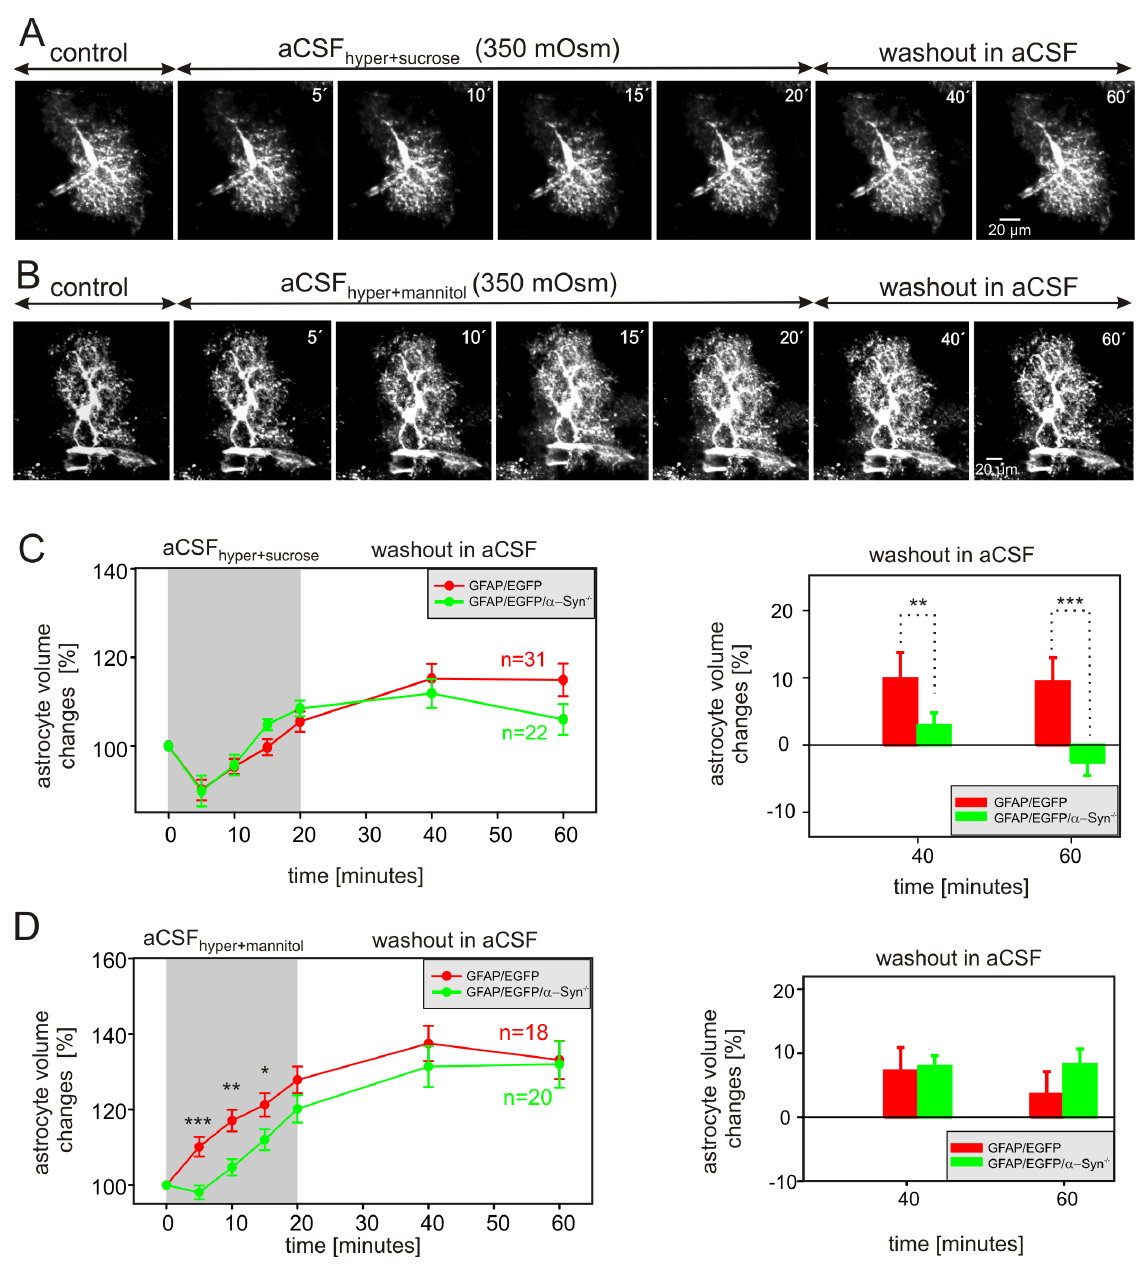
Figure 5. Astrocytic volume changes in the cortex of GFAP/EGFP and GFAP/EGFP/ a -Syn 2 / 2 mice during hyperosmotic stress. ( A, B ) Superimposed confocal images of EGFP-labeled astrocytes in the cortex of GFAP/EGFP/ a -Syn 2 / 2 mice recorded in aCSF (control), during a 20-minute exposure to hyperosmotic stress of 350 mOsm/kg using sucrose-containing aCSF (aCSF hyper-sucrose , A ) or mannitol-containing aCSF (aCSF hyper-mannitol , B ), and during a 40-minute washout. The astrocytic volume was quantified after every 5 minutes during exposure to hyperosmotic stress and every 20 minutes during washout. Time-dependent changes in the total astrocytic volume in GFAP/EGFP (red) and GFAP/EGFP/ a -Syn 2 / 2 mice (green) during a 30-minute exposure to aCSF hyper-sucrose ( C left ) or during a 30-minute application of aCSF hyper-mannitol ( D left ) and during a 60-minute washout. The changes of astrocytic volume during washout were evaluated in each individual cell and were expressed as an average percent of cell volume increase/decrease related to the maximal volume after 20 minutes of aCSF hyper-sucrose ( C right ) or aCSF hyper-mannitol application ( D right ); these values were set as 0%. Asterisks indicate significant (*, p , 0.05), very significant (**, p , 0.01) and extremely significant (***, p , 0.001) differences between GFAP/EGFP and GFAP/ EGFP/ a -Syn 2 / 2